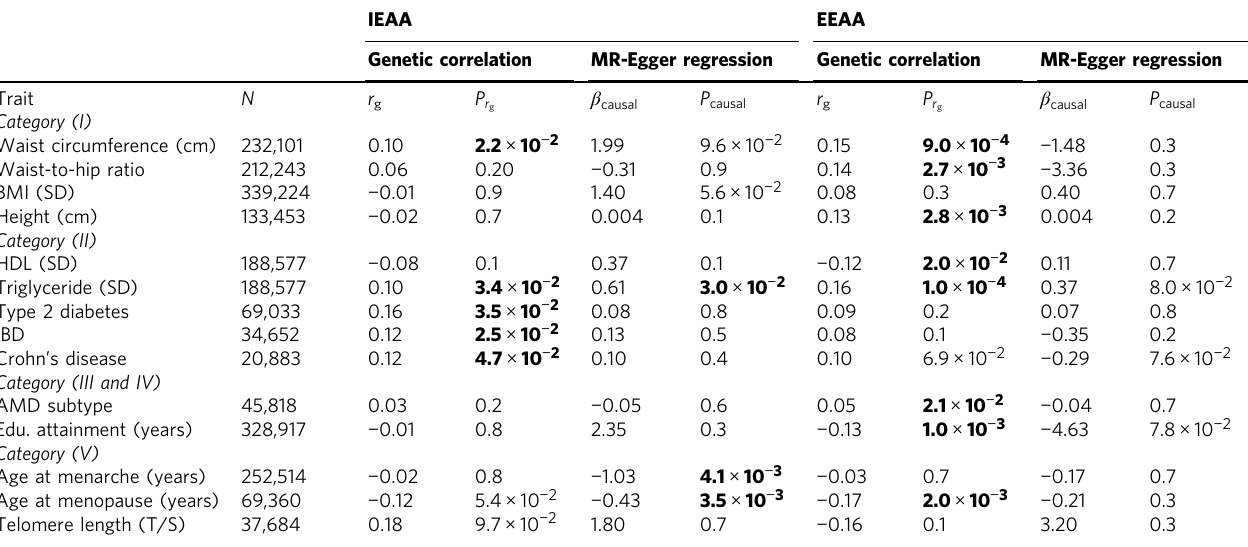
Table 4 Genetic correlations with and causal effects of other complex traits on epigenetic age